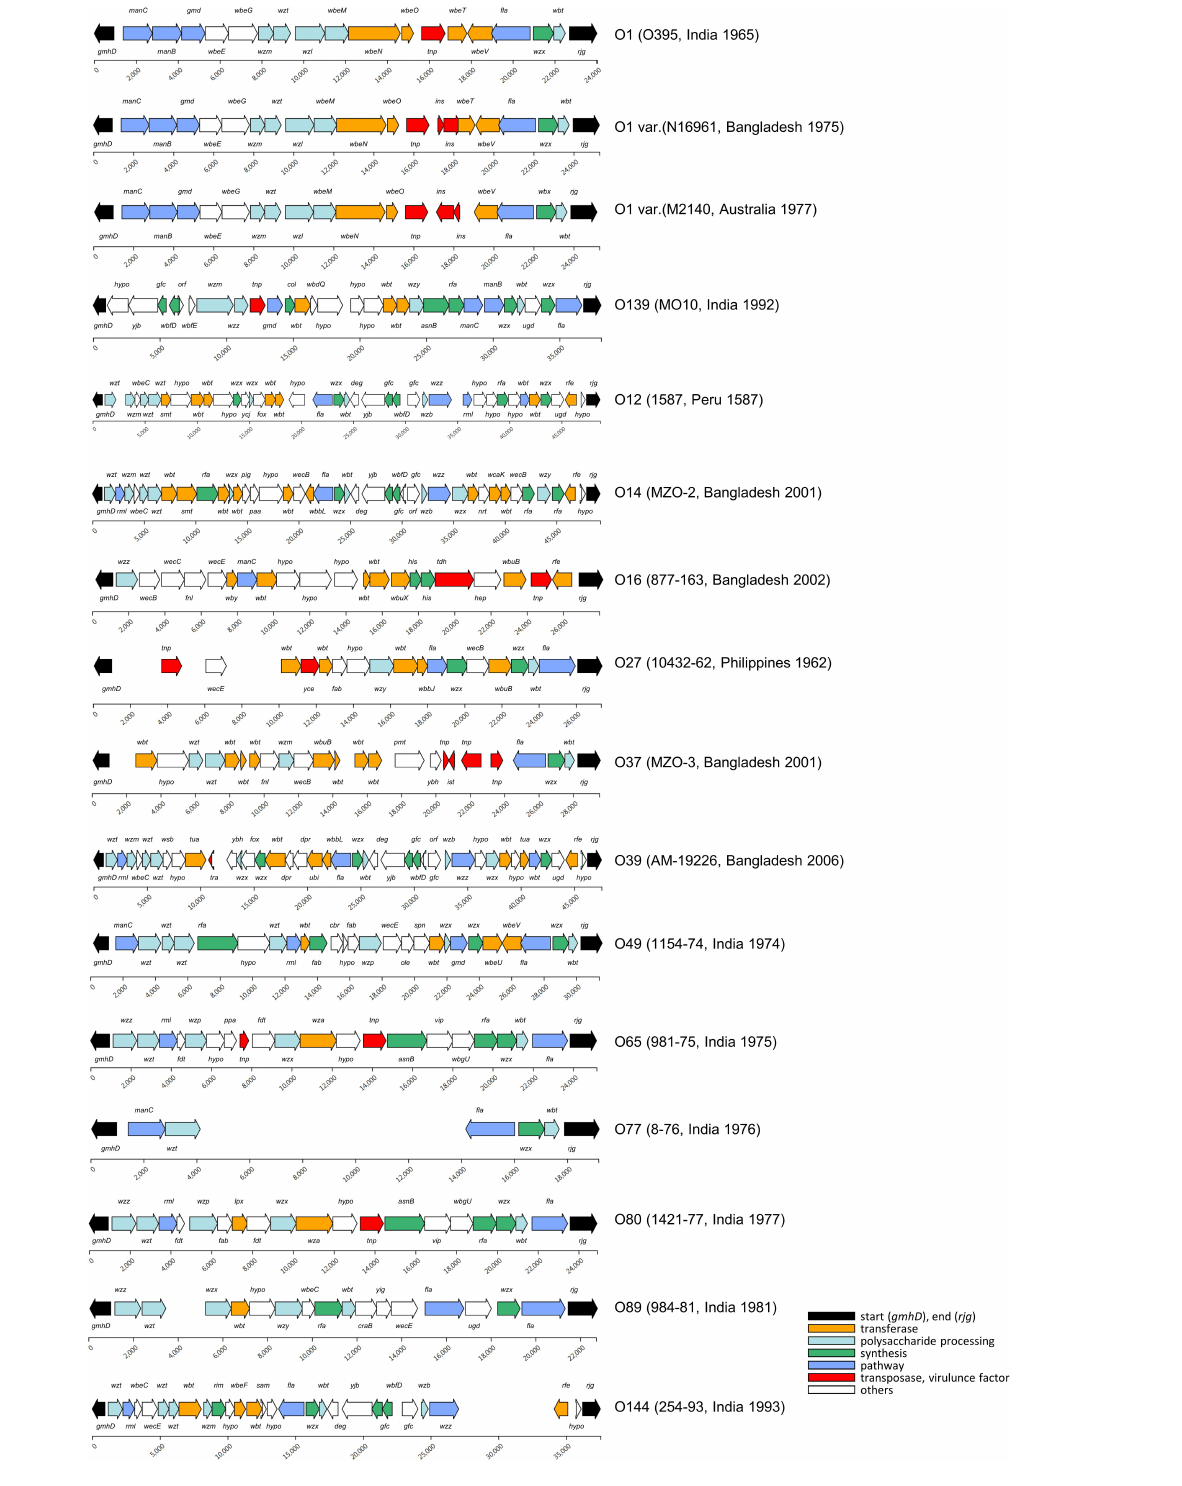
Frontiers in Microbiology |